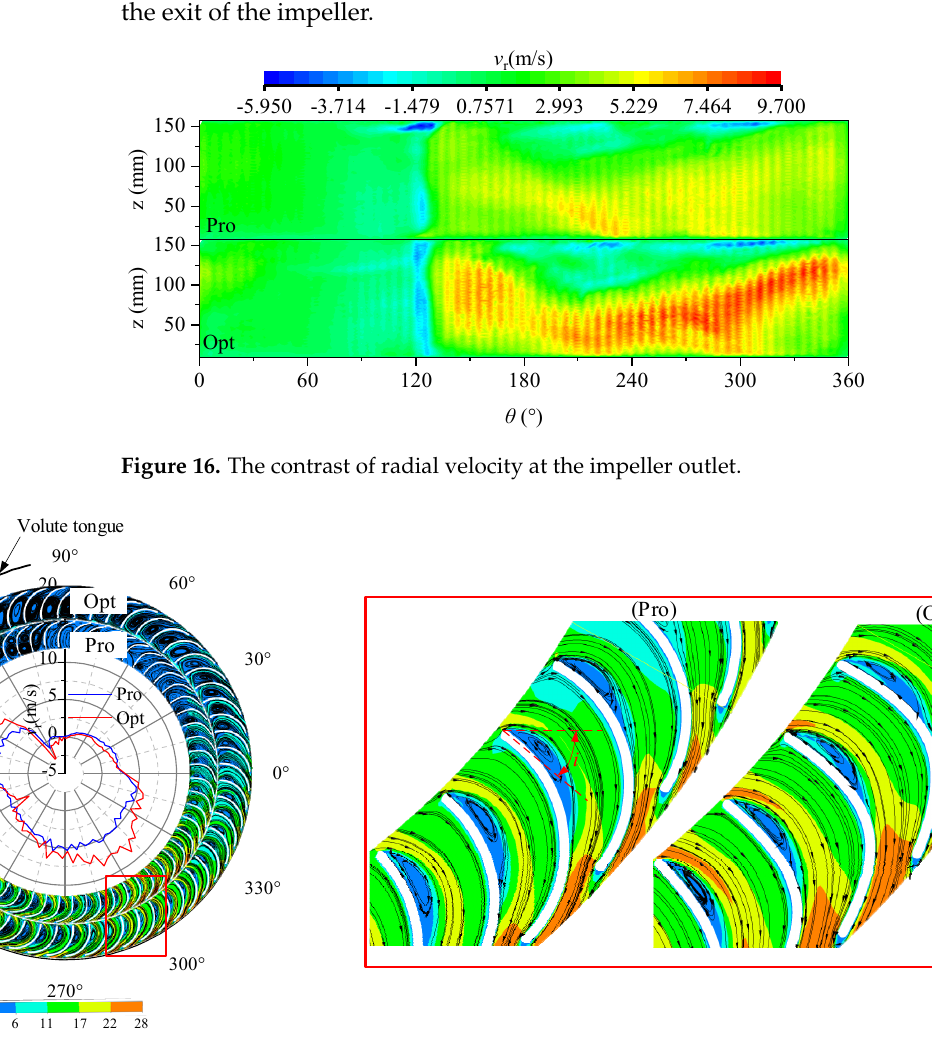
Figure 18. Change of cross-sectional area with diameter D . The airflow in the area near the volute tongue is shown in Figure 19. The airflow near the volute tongue can be divided into three parts: the airflow discharged from the volute Q dis , the airflow recirculated into the volute Q rec , and the airflow reversed into the impeller 210